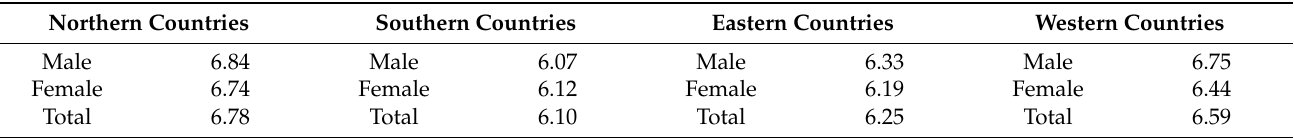
Table 2. Life satisfaction of men and women in European